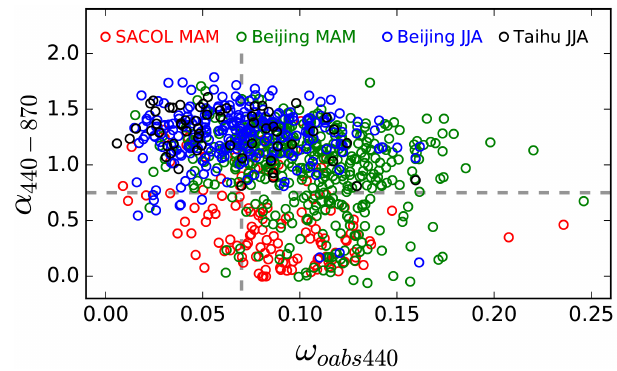
Figure 10. Aerosol extinction coefficient profiles for the following regions: (a) the Taklamakan Desert (TD); (b) the Tibetan Plateau (TP); (c) the Loess Plateau (LP); (d) the Northeast China Plain (NEP); (e) the Sichuan Basin (SB); (f) the North China Plain (NCP); (g) the Yangtze River Delta (YRD); and (h) the Pearl River Delta (PRD). The height is defined as the altitude above the sea